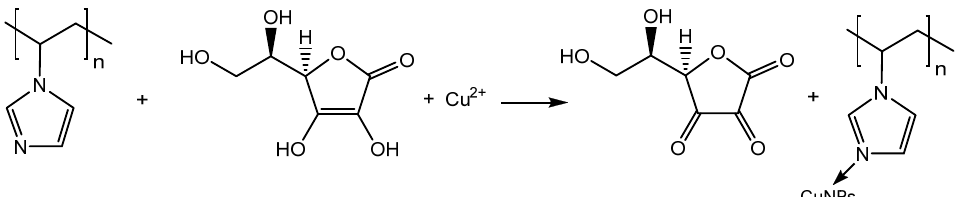
Figure 4. UV spectra of aqueous solutions of polymer nanocomposites 2 ( a ) and 4 ( b ). Electronic absorption spectra of nanocomposites 1 – 4 were recorded after adding copper acetate monohydrate to a mixture of polymer and ascorbic acid at different times. The surface plasmon band with an absorption maximum in the range of 535 – 557 nm, caused by the collective oscillation of conduction electrons on the surface, confirms the formation of CuNPs. The formation of CuNPs in solution was observed after 20 min. The